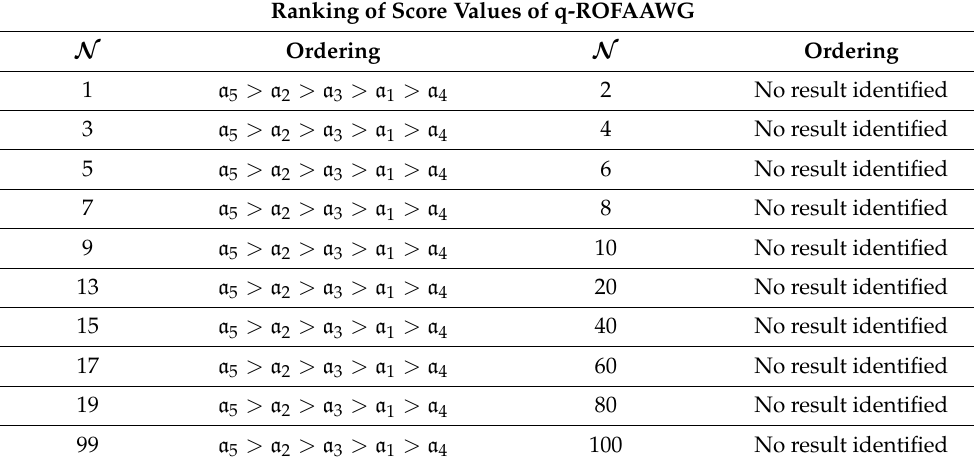
Table 7. The ranking order of score function by changing in N q-ROFAAWG operator. Ranking of Score Values of q-ROFAAWG